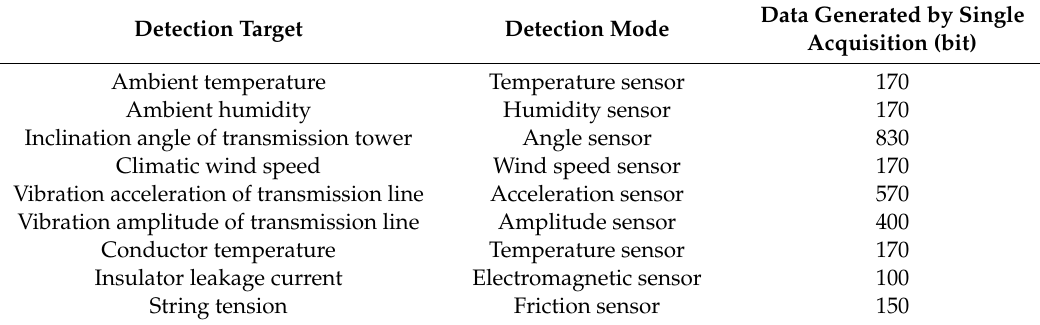
Table 1. Monitoring node sensor data.